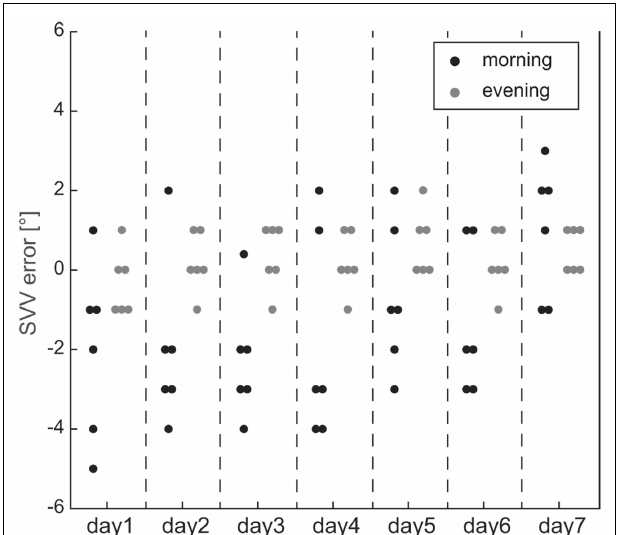
FIGURE 2 | Illustrative example of SVV adjustments in a single subject (#7) . Individual adjustment errors are indicated by dots. The comparison between morning (black dots) and evening (gray dots) recording sessions (showing recordings from all 7days) indicated overall larger trial-to-trial variability for all morning sessions.